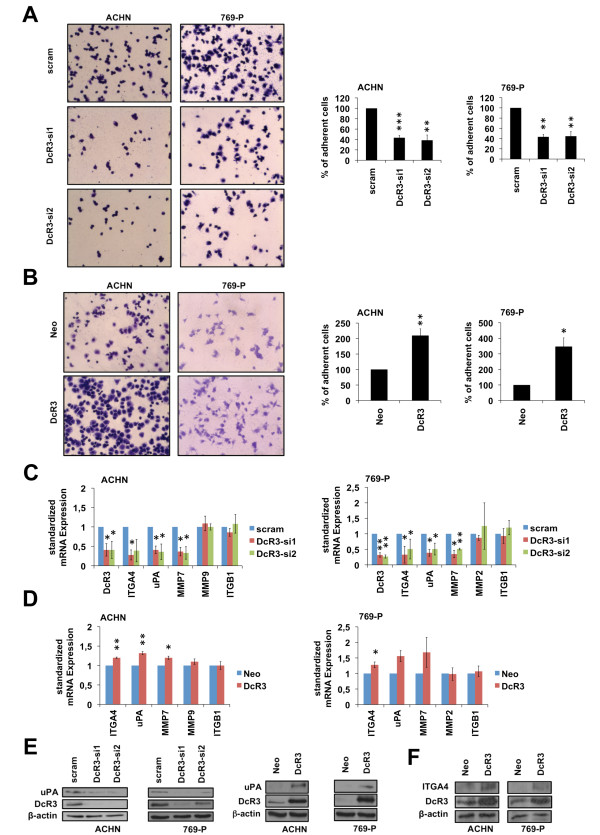
DcR3 modulates cell adhesion to ECM component fibronectin. (A,B) Adhesion assay of ACHN and 769-P cells transfected with two different DcR3-specific siRNAs or a non-specific siRNA (scram) (A) or stably overexpressing DcR3 or an empty vector control (neo) (B). Bars indicate the percentage of cell adhesion compared to control cells. Adherent cells were counted in five representative fields (mean ± SEM; n=3, *p<0.05, **p<0.01; ***p<0.001; T-test). Representative images are shown (magnification: 100×). (C,D) Quantitative real-time-PCR assaying relative expression levels of DcR3 and invasion-relevant genes in ACHN and 769-P cells transfected with two different DcR3-specific siRNAs or a non-specific siRNA (scram) (C) or stably overexpressing DcR3 or an empty vector control (neo) (D). Expression data were normalized to internal 18S rRNA expression. Bars indicate fold changes of RNA level in relation to control cells (mean ± SEM; n=3; *p<0.05; **p<0.01; T-test). (E) Immunoblot analysis of whole-cell lysates showing uPA protein level in ACHN and 769-P cells transfected with two different DcR3-specific siRNAs, a non-specific siRNA (scram) or stably overexpressing DcR3 or empty vector control (neo). (F) Immunoblot analysis of whole-cell lysates showing ITGA4 protein level in ACHN and 769-P cells stably overexpressing DcR3 or an empty vector control (neo).